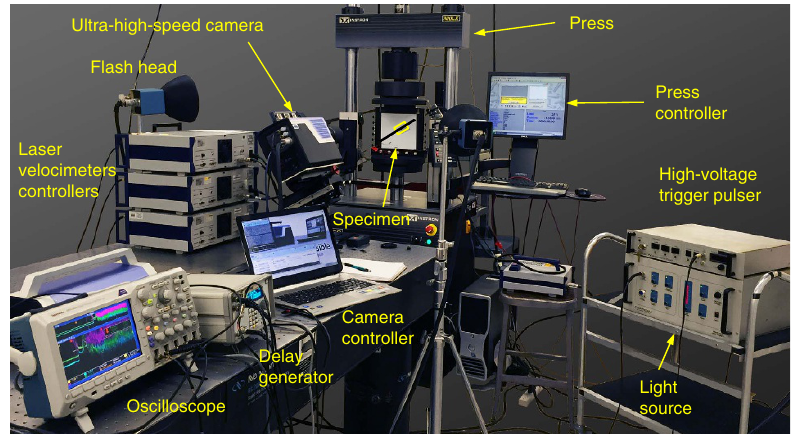
Figure 2 | Laboratory earthquake set-up with the ultrahigh speed digital image correlation and laser velocimeter diagnostics. The sample contains an interface that mimics a crustal fault prestressed both in compression and in shear. Dynamic rupture is triggered through a local pressure release provided by a rapid expansion of a NiCr wire filament due to an electrical discharge. The Shimadzu HPV-X ultrahigh speed camera records images of the specimen during rupture propagation at 1–2 million frames per s. The well-developed technique of laser velocimetry is used for comparison of pointwise velocity measurements obtained with the full-field technique at selected